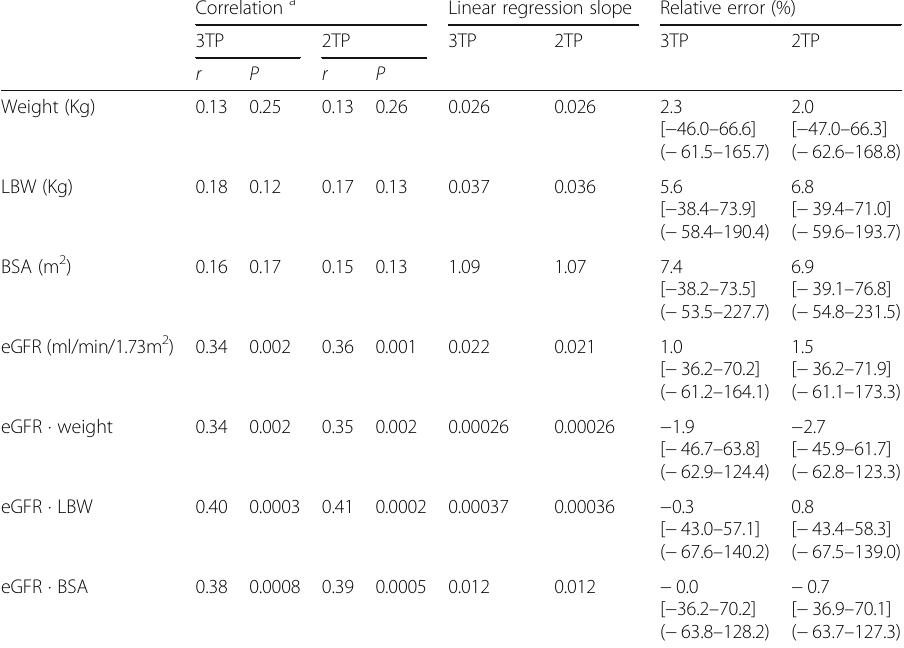
Table 7 Correlation between body size predictors, eGFR, and the IA per renal absorbed dose (GBq/Gy) at the first induction cycle ( n = 77) Correlation a Linear regression slope Relative error (%)